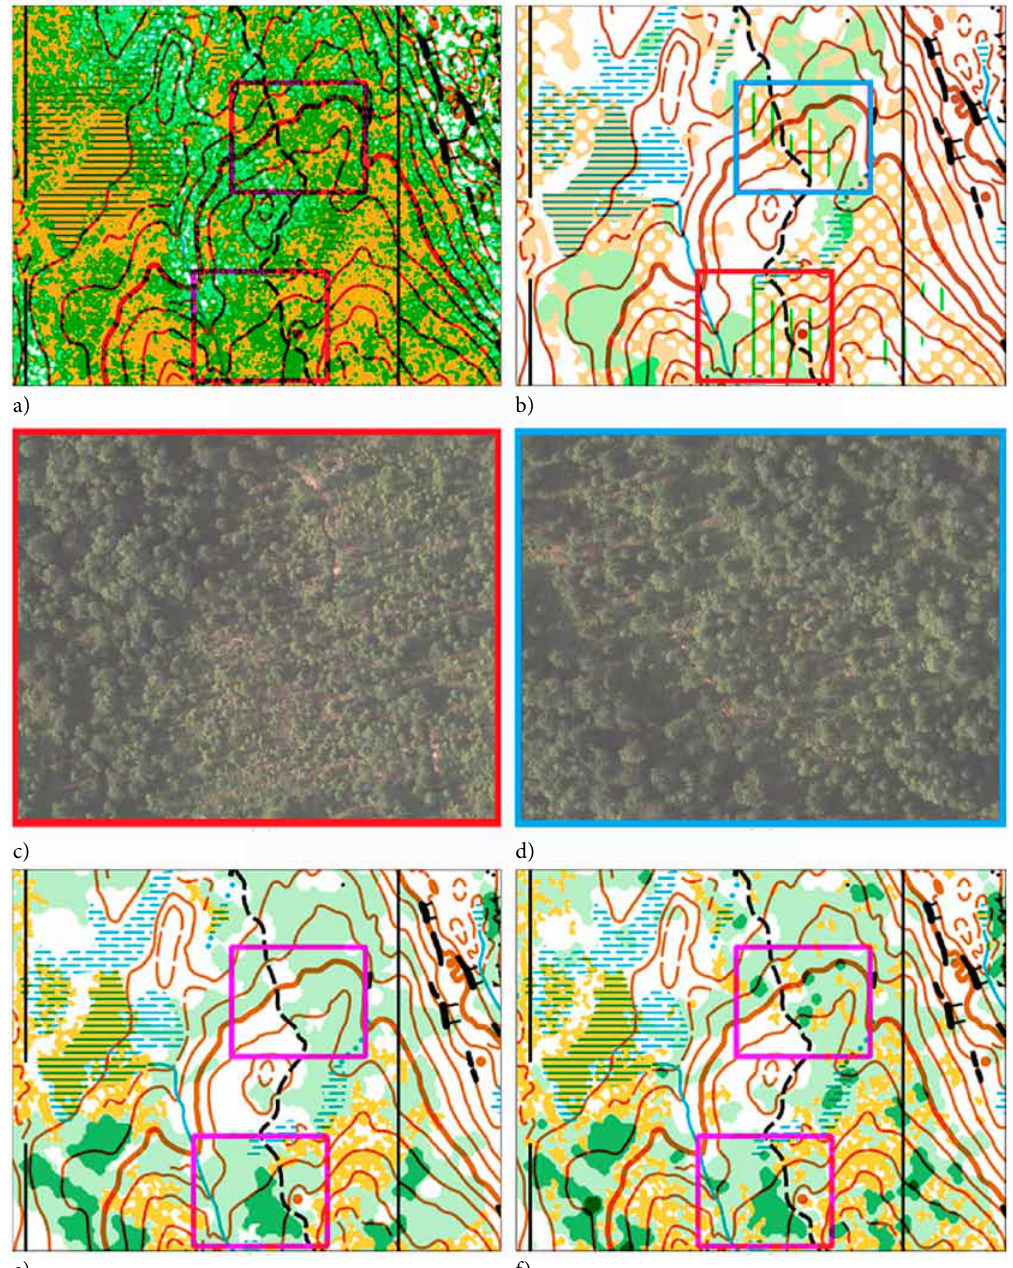
Fig. 9. Inspection of mapping results for a small portion of the Tømte area. (a) Vegetation height: dark yellow = 0.0–0.1 m, light yellow 0.1–1.0 m, dark green = 1–7 m, light green = 7–12 m, white > 12 m. (b) Manual survey. (c–d) Small portions of air photo of summer 2013, for the (c) southern rectangle and the (d) northern rectangle. (e) Automatic vegetation mapping, with 225 m 2 minimum size of half-tome areas. (f) As (e), but with 22.5 m 2